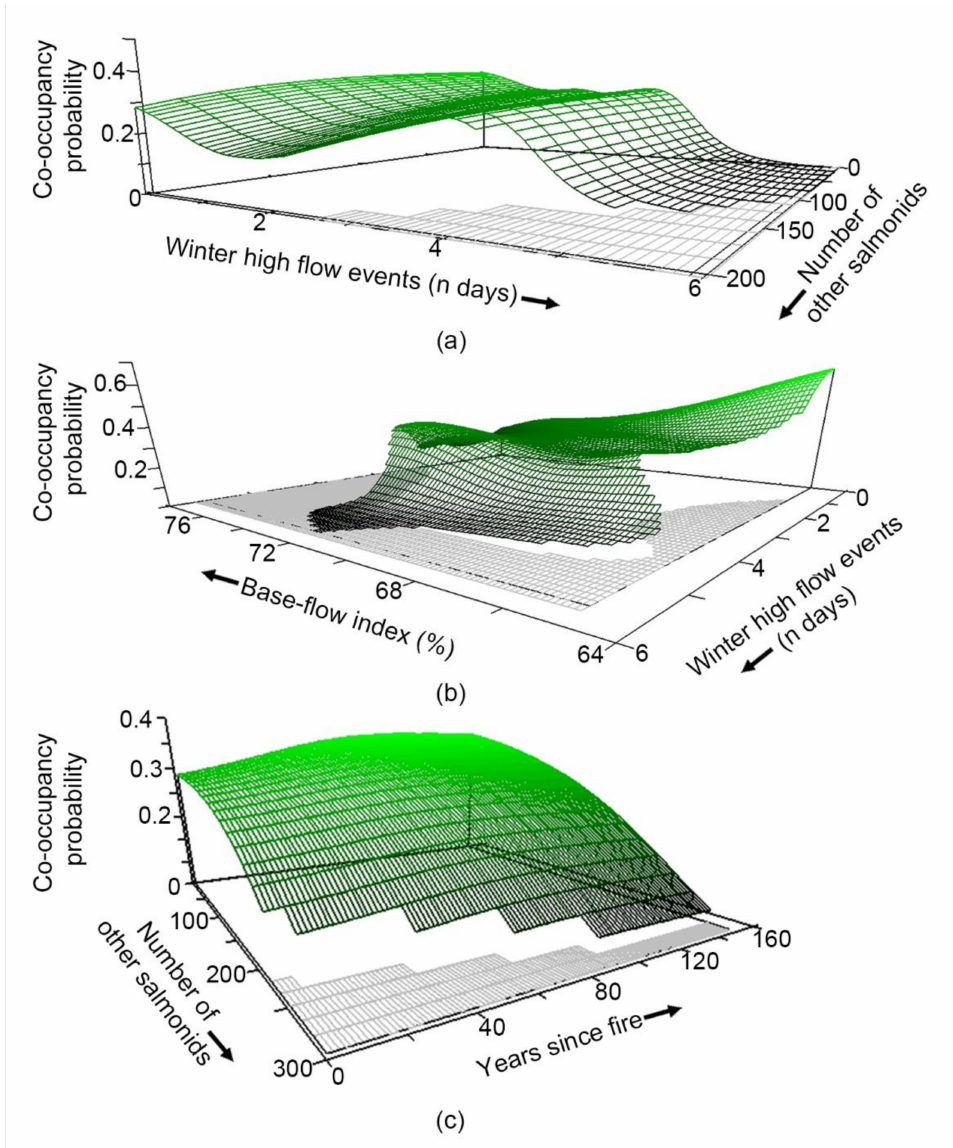
Figure 5. NPMR modeled relationships between tailed frog and bull trout co-occupancy rate (vertical axes) and ( a ) number of salmonids detected in the stream reach (other than bull trout) and winter high flow events (number of winter days when stream flows are in >95 percentile of the flow of record), ( b ) Base-flow index, a measure of streamflow stability and winter high flow events, and ( c ) number of other salmonids and number of years elapsed between wildfire and survey. This model was developed from 481 sites sampled within the ranges of the Rocky Mountain tailed frog and bull trout. Gray shading in each panel indicates regions of predictor space with insufficient data for predictions to be